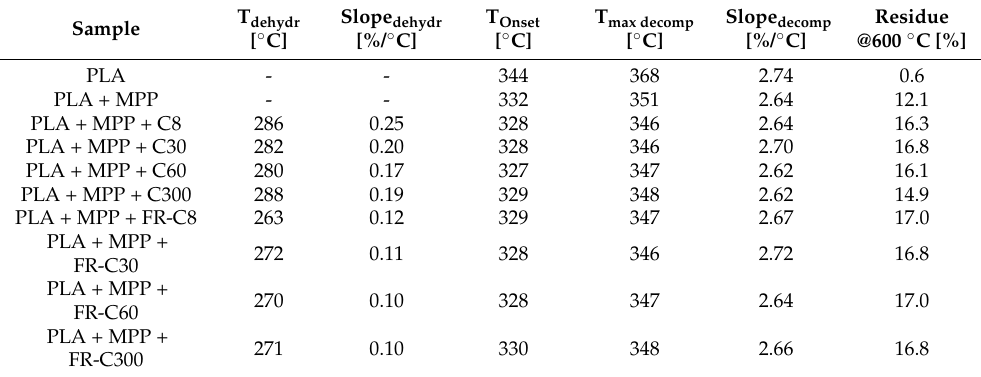
Table 7. TGA results of the composites samples with differing cellulose fibre length.